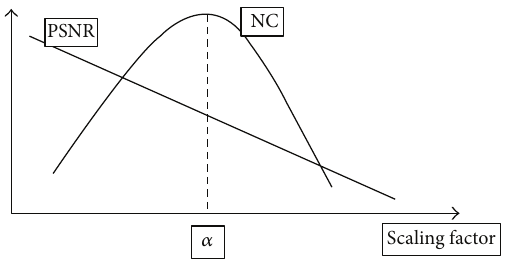
Figure 9: Two-level interlacing.